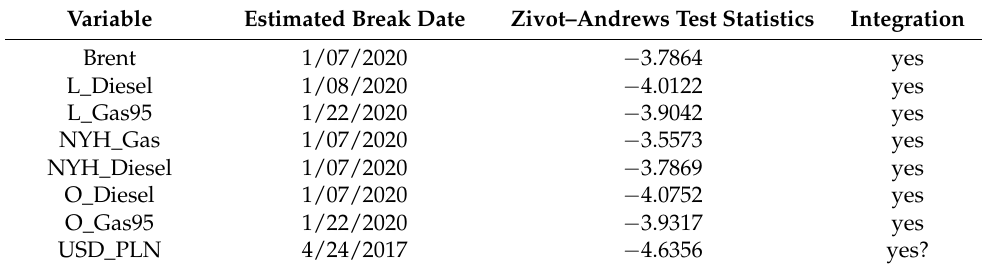
Figure 4. Zivot–Andrews breakpoints (marked by vertical, grey line). Table 5. Zivot–Andrews unit root